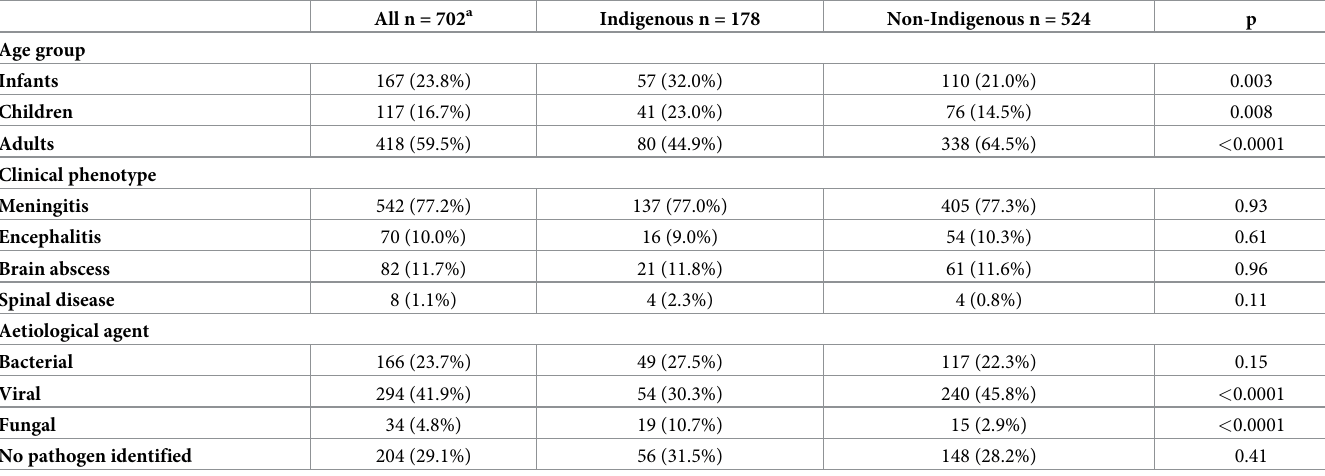
Table 2. The number of cases in Indigenous and non-Indigenous Australians stratified by age, clinical phenotypes and aetiological agent. All n = 702